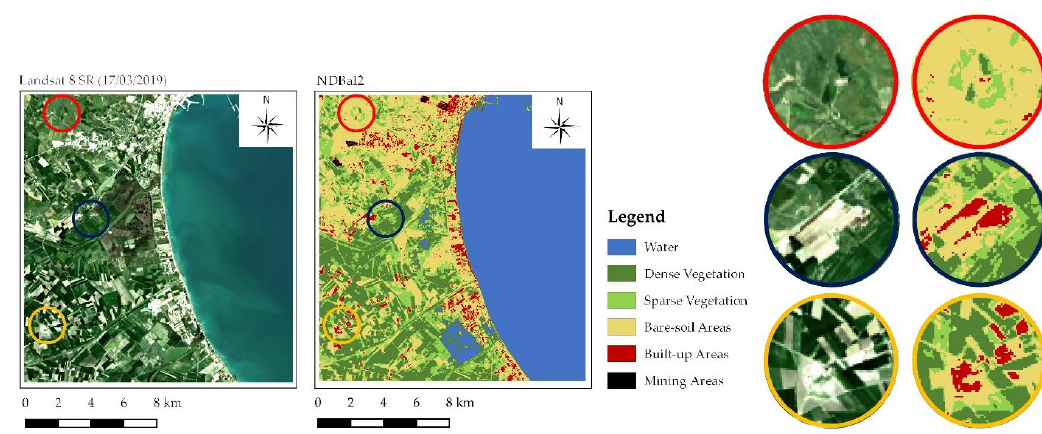
Figure 6. Normalized Di ff erence Bareness Index 2 (NDBaI2) classification outcome for Landsat 8 (image acquired on 17 March 2019). On the right, zoomed images with some misclassifications.